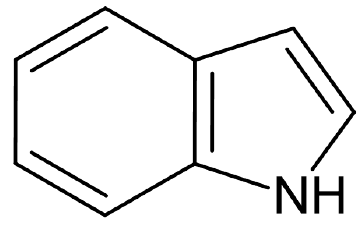
Figure 1. Indole